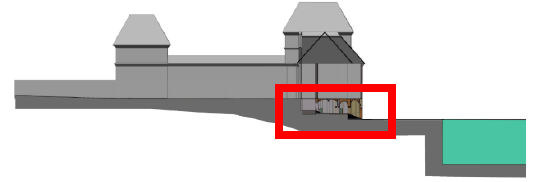
Figure3. HBIM model of the Valentino Castel (Turin) and focus on the HBIM model of “hall of columns”